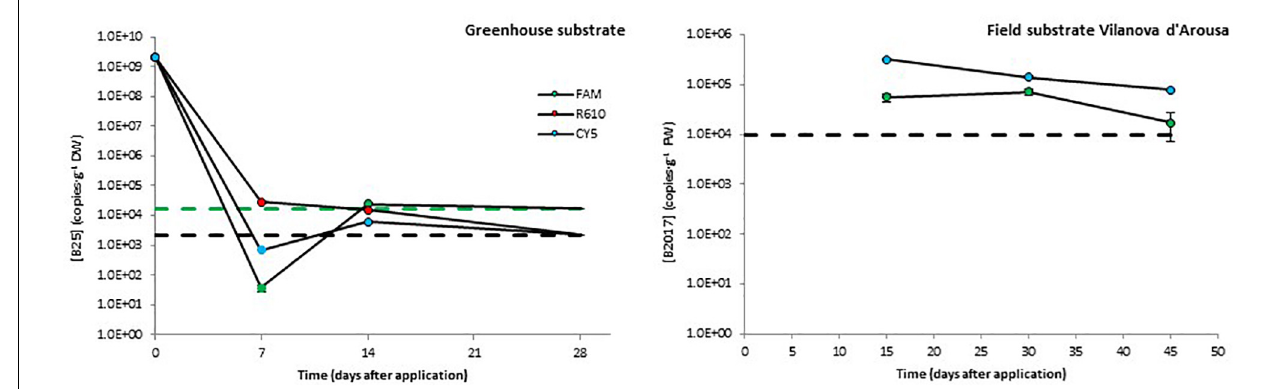
FIGURE 3 | Persistence of two biocontrol bacterial strains (B25 and B2017) in soils of different natures. The presence of B2021 in the substrate from a field trial in Picanya was below detection limits (2.4 × 10 3 CFU · g − 1 ) 36, 64, and 86 days after application. Bacterial concentrations were measured with three markers per strain (only two for B2017), labeled with different fluorophores (FAM, CY5, and R610 [LightCycler Red 610]). Dashed lines represent the limits of detection (in black when those of several channels overlap). Data points below detection limits are omitted except for those helpful to obtain a view of the overall trend, which are shown with no edge. Negative controls (untreated soils) yielded concentrations below detection limit in all cases (not shown).